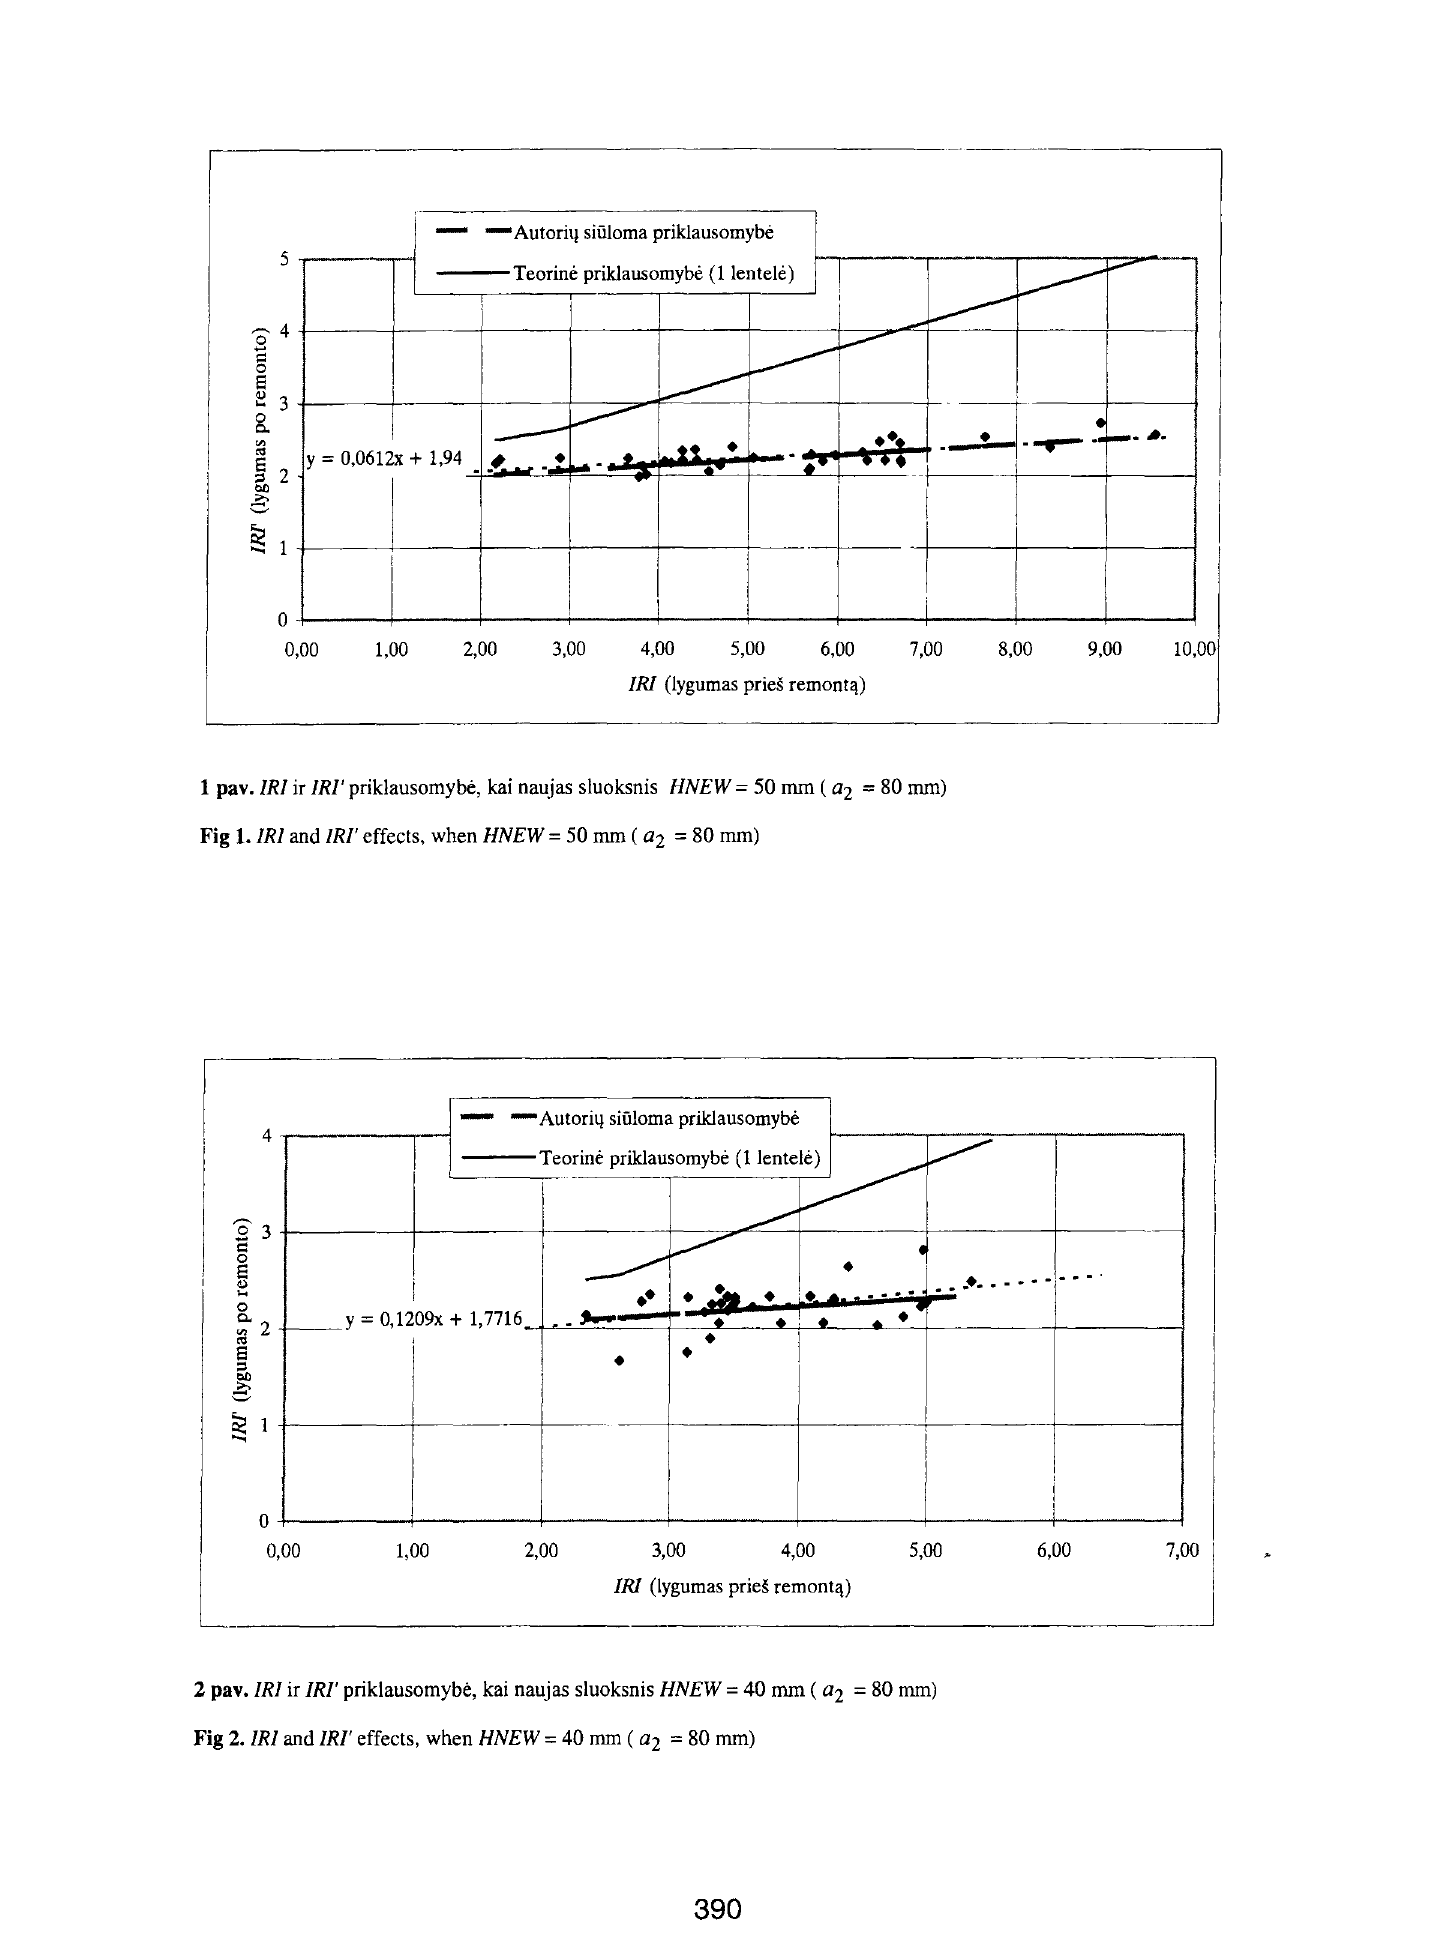
Fig 2. IRI and IRI' effects, when HNEW = 40 mm ( a2 = 80 mm)